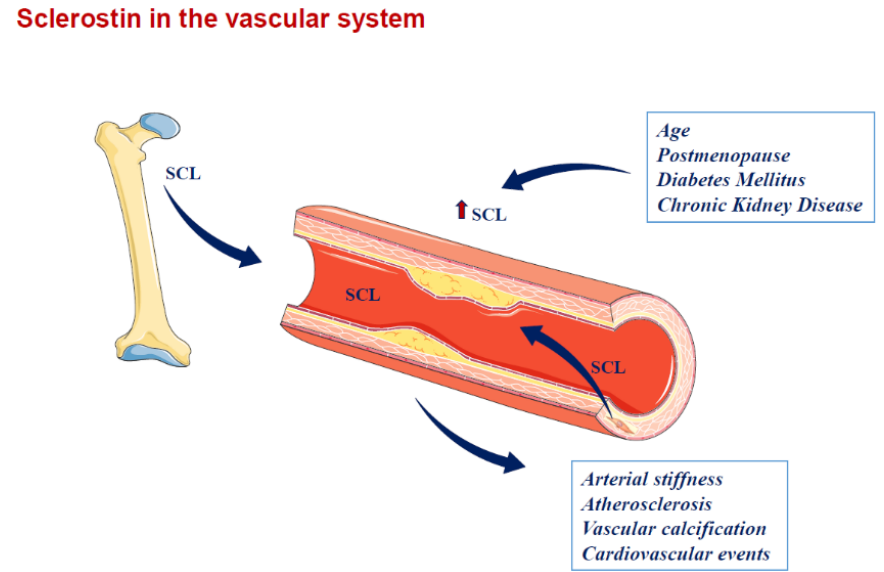
Figure 2. Sclerostin in the vascular system. SCL is produced by osteocytes at bone level and may drive the paracrine effect. SCL also spills over the circulation and may contribute to vascular pathophysiology (e.g., atherosclerosis, arterial stiffness and vascular calcification). SCL is also up-regulated in calcifying vascular smooth muscle cells at the vascular level. SCL = sclerostin. Arrows indicate the spill over of sclerostin from the sites where it is produced into circulation and the related factors or diseases associated with higher sclerostin circulating levels.